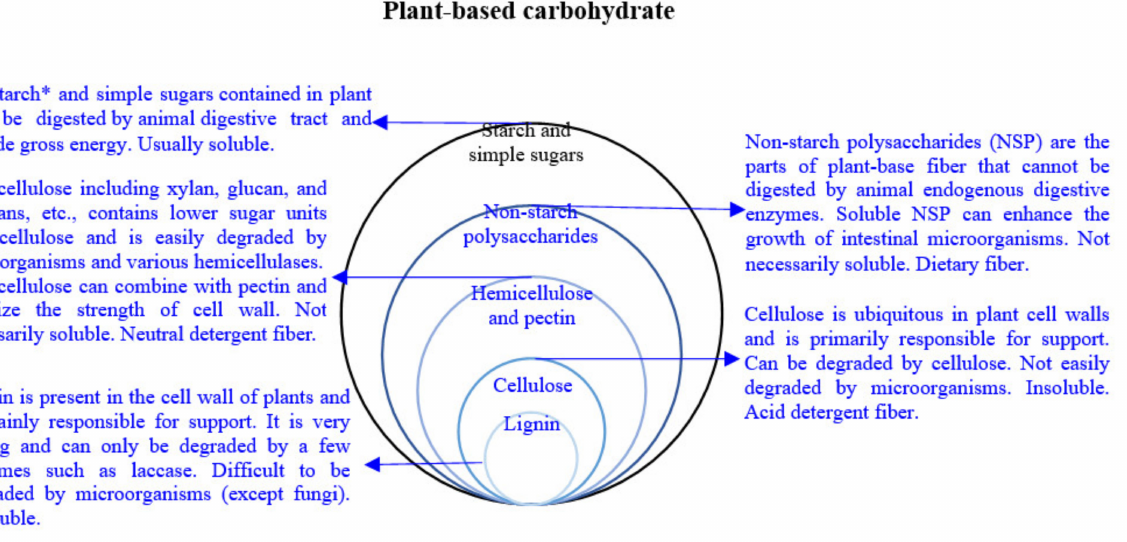
Figure 1. The classification and characteristics of carbohydrates in plants. * Resistant starch is beyond the scope of this